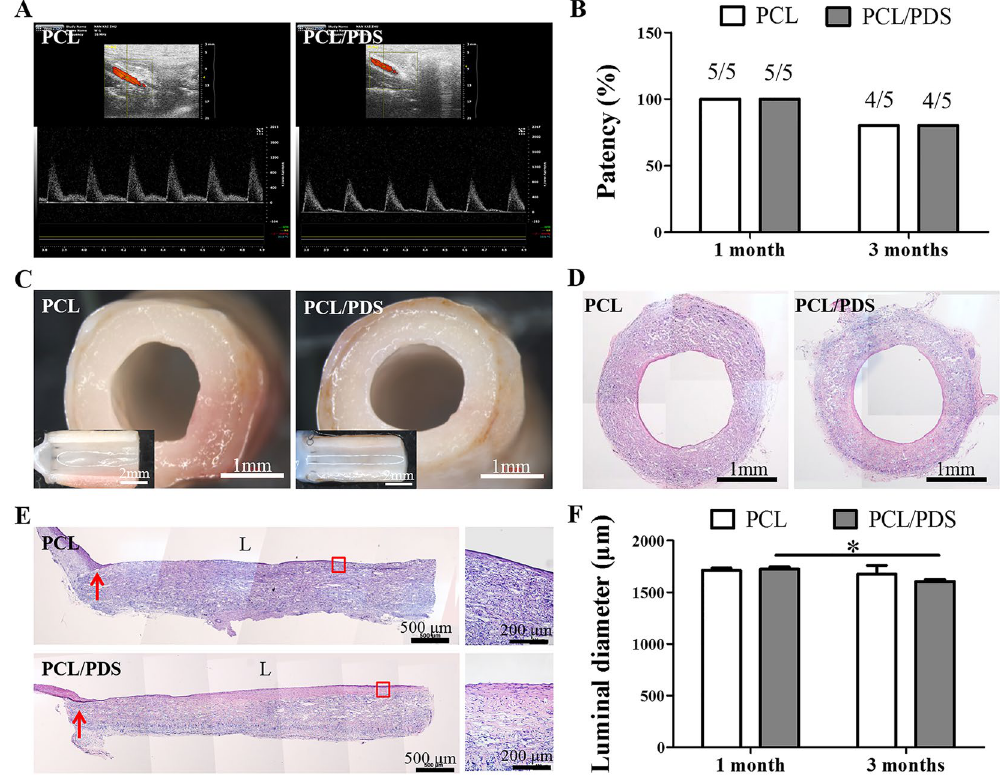
Figure 2. Evaluation of the patency and luminal diameter of explanted grafts at 3 months after implantation. ( A ) The patency was measured by color Doppler ultrasound. ( B ) The patency rates of the PCL and PCL/ PDS grafts at both time points. ( C ) The lumen of the explanted grafts was smooth and free of thrombus under stereomicroscope. ( D ) Cross sections were stained with H&E to identify the neointima formation. ( E ) Representative H&E staining of longitudinal sections of explanted grafts. ( F ) The luminal diameter of explanted grafts was calculated based on the cross sections with H&E staining. ( L ) lumen; Red arrows: suture site. * p < 0.05.